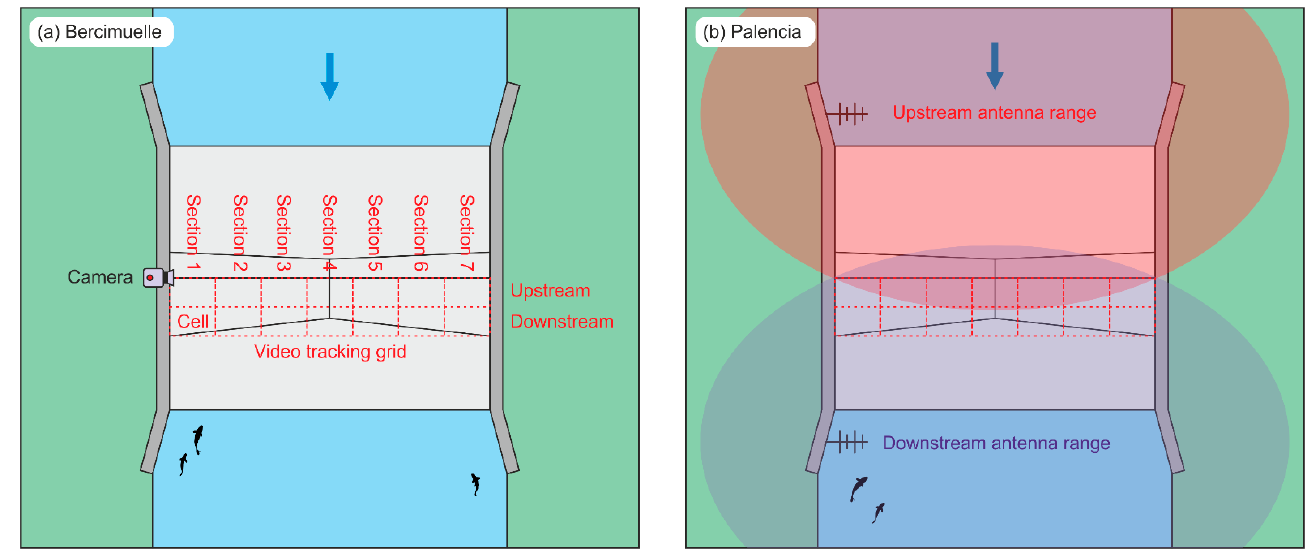
Figure 5. ( a ) Scheme of the video recording in the Bercimuelle weir with the used grid to characterize the ascent paths of the fish. ( b ) Scheme of the radio-tracking in the Palencia weir showing the two fixed radio antennas and their detection range.